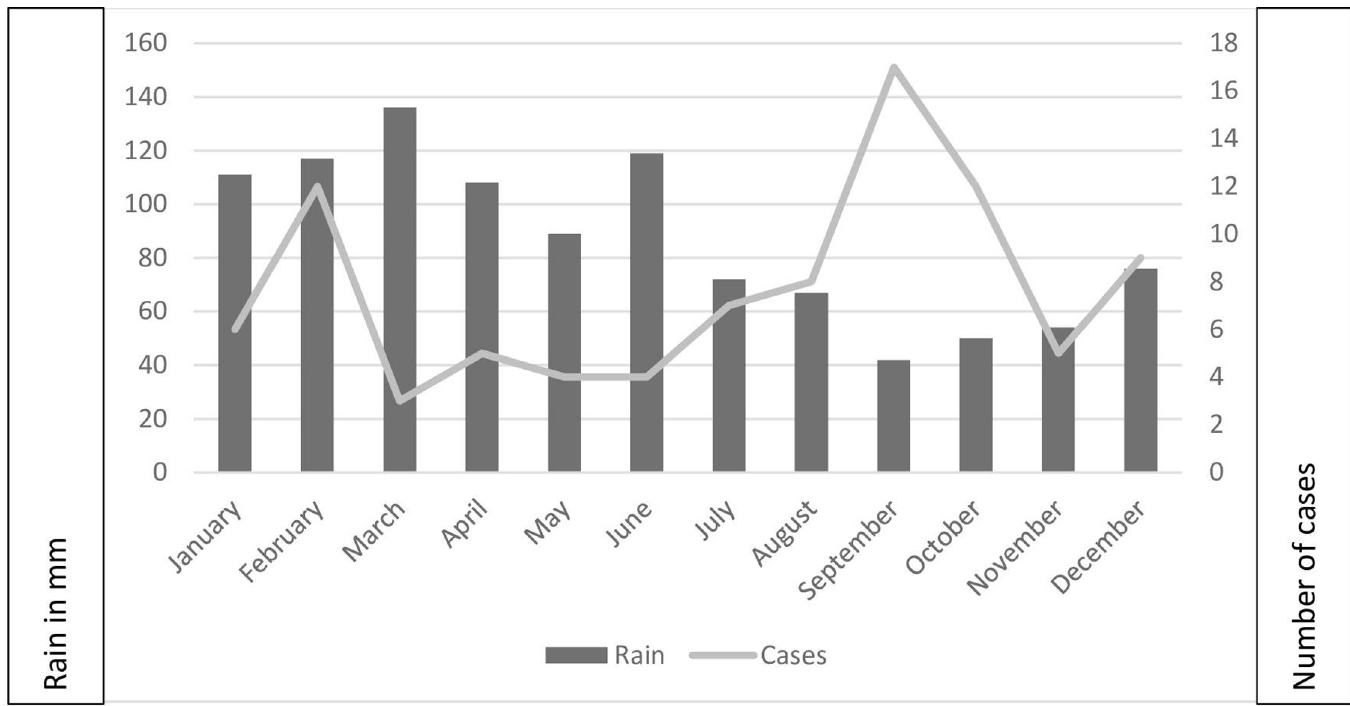
Fig 1. Monthly distribution of the New-Caledonian cases according to average rainfall in mm in Noumea, from 2004 to 2019, n = 92.